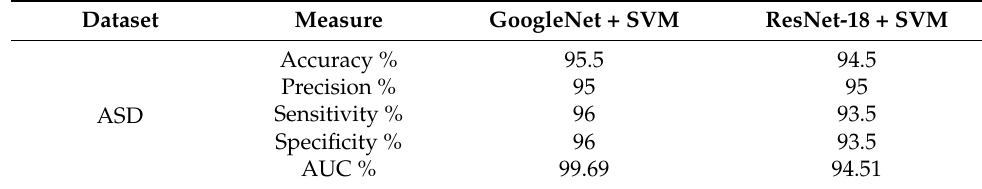
Table 8. Performance of GoogleNet + SVM and ResNet-18 + SVM systems on ASD dataset. Dataset